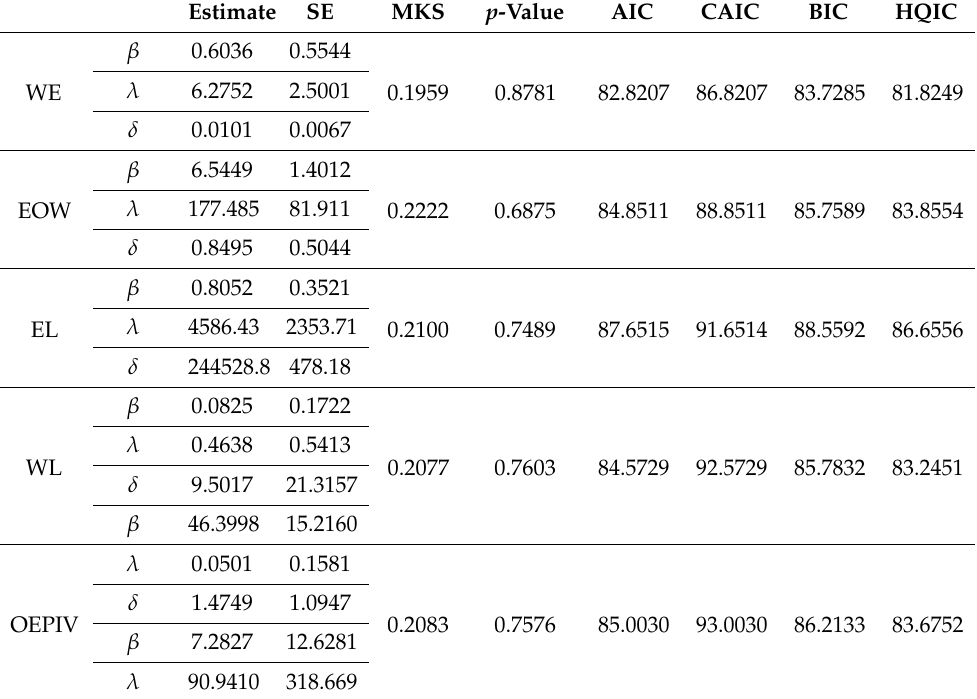
Table 4. MLE for parameters of WE distribution and commonly known distributions under PTIICS for real